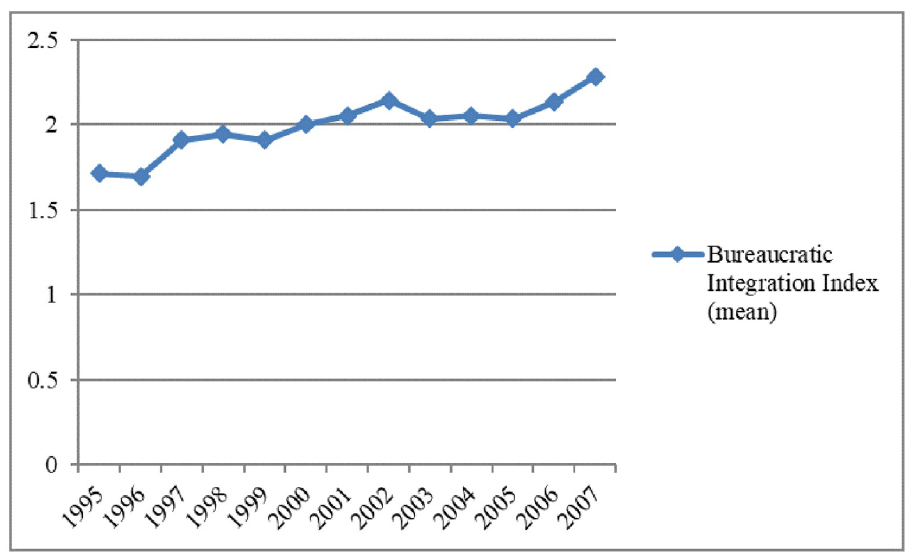
Fig 1. Bureaucratic integration (sample average), 1995–2007. Sources: the author with reference to [10].